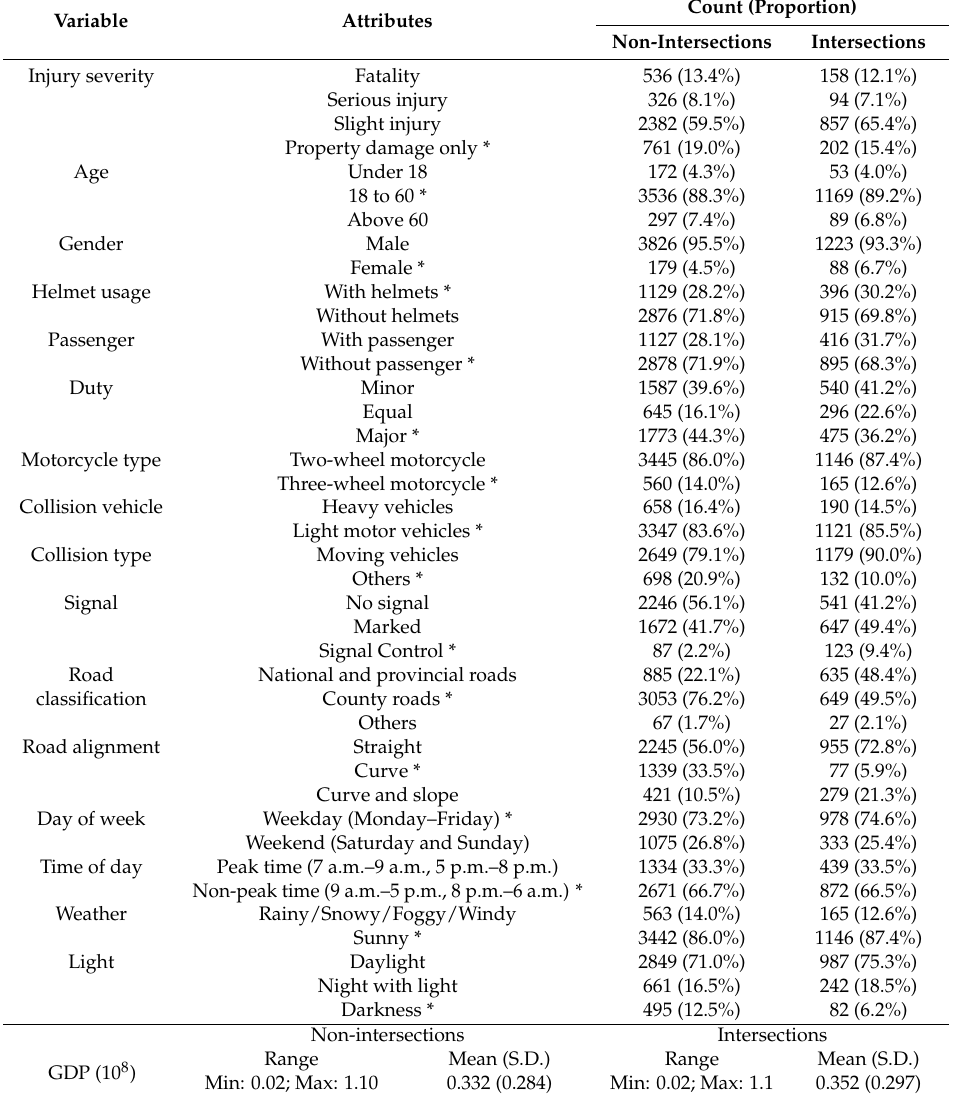
Table 1. Descriptive statistics of variables included in the